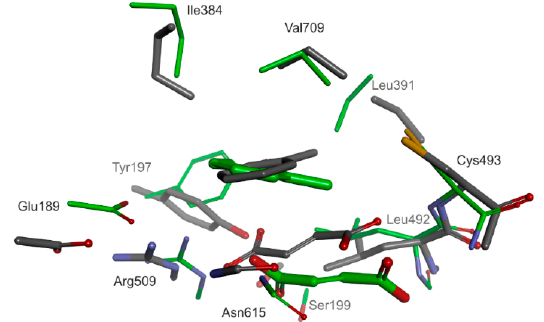
Figure 6. Comparison of the bound substrates in BSS as predicted in our model ( grey ) and a recent crystallographic study ( green ).